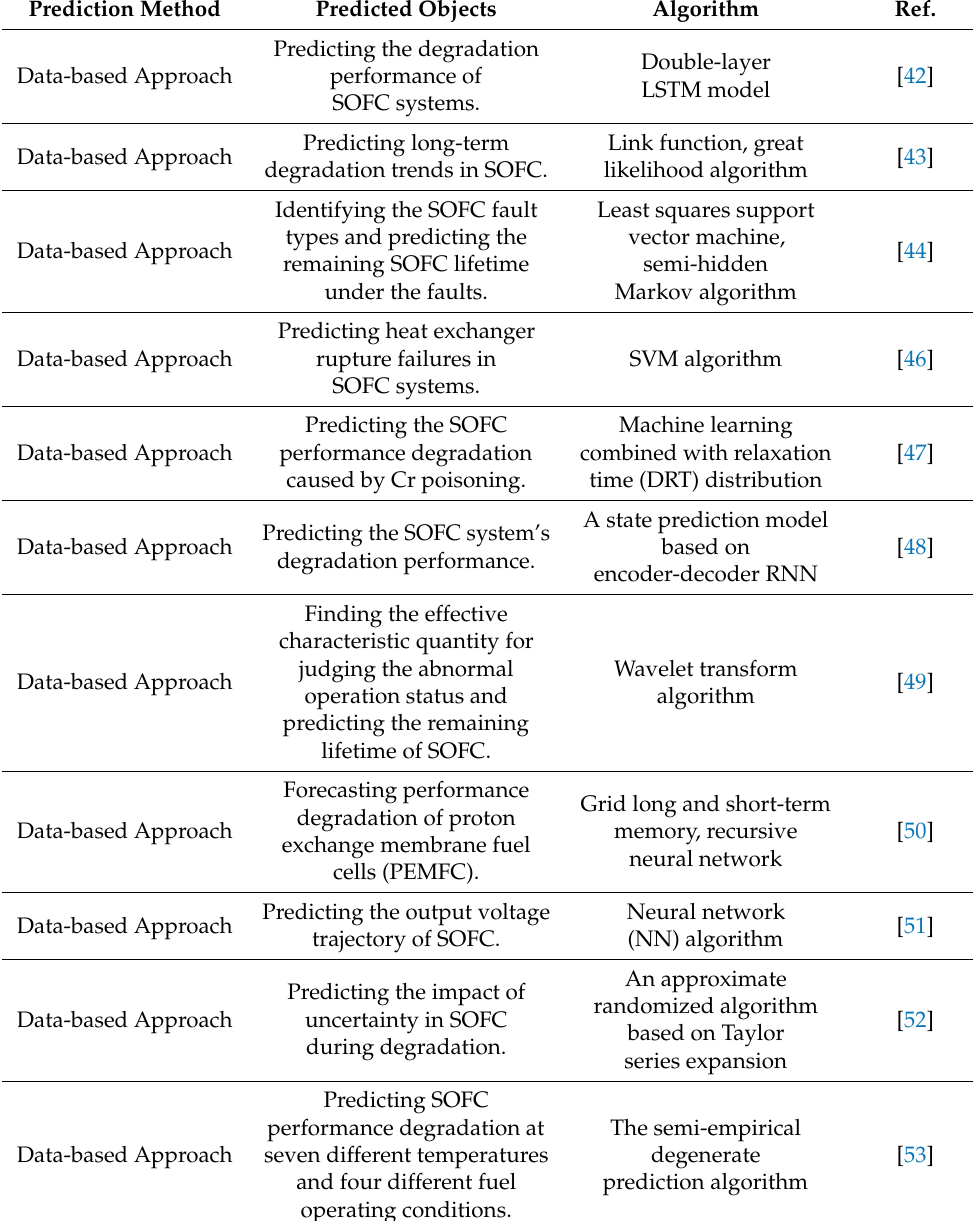
Table 3. Data-based study on SOFC degradation performance